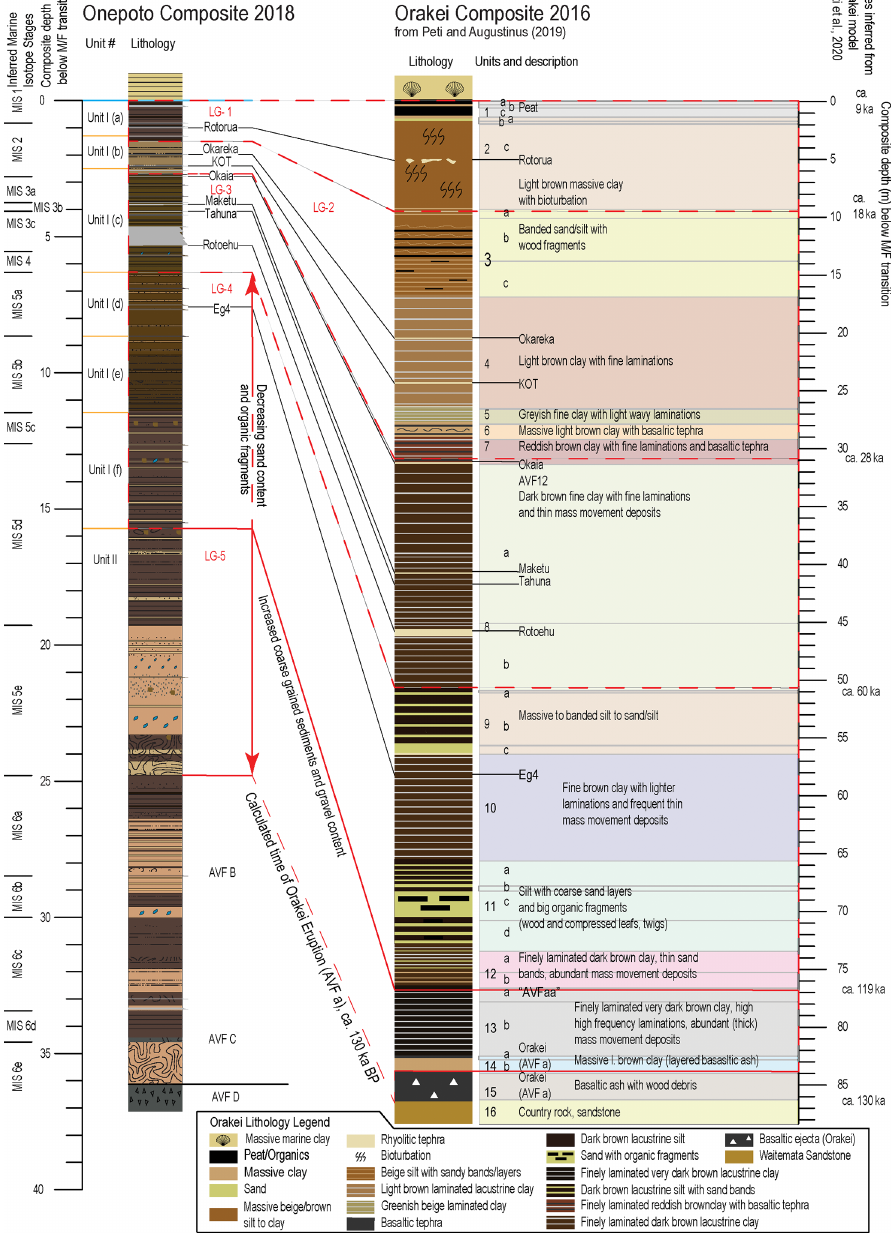
Figure 8. Comparison of lithostratigraphic units identified in the Onepoto and Orakei maar lake records as well as inferred correlations to the MIS 6e–MIS 1 (where MIS represents marine isotope stage). Orakei Basin lake sediment facies model modified from Peti and Augustinus (2019). Lithology legend for Onepoto follows that in Fig. 3. Red dashed lines show corresponding facies transitions; black dashed lines show possibly correlatable tephra beds; red solid lines show transition from sediments with less sandy/coarse content to sediments with increased coarse-grained content; black solid lines show correlatable tephra beds; and the dashed blue line represents the marine–freshwater transition.